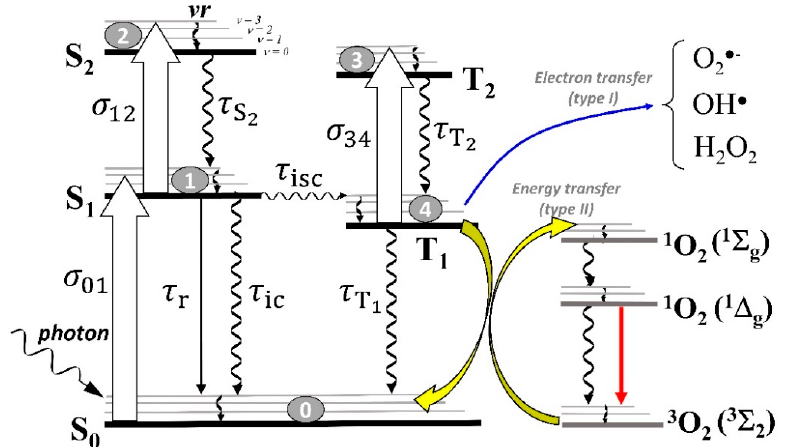
Figure 1. Five-level-energy diagram showing photophysical characteristics of a typical PS and the ROS production that occurs in the photodynamic application. S i and T i are the singlet and triplet states, σ ij are the absorption cross-sections between i and j states. τ are the lifetimes of the relaxation processes.